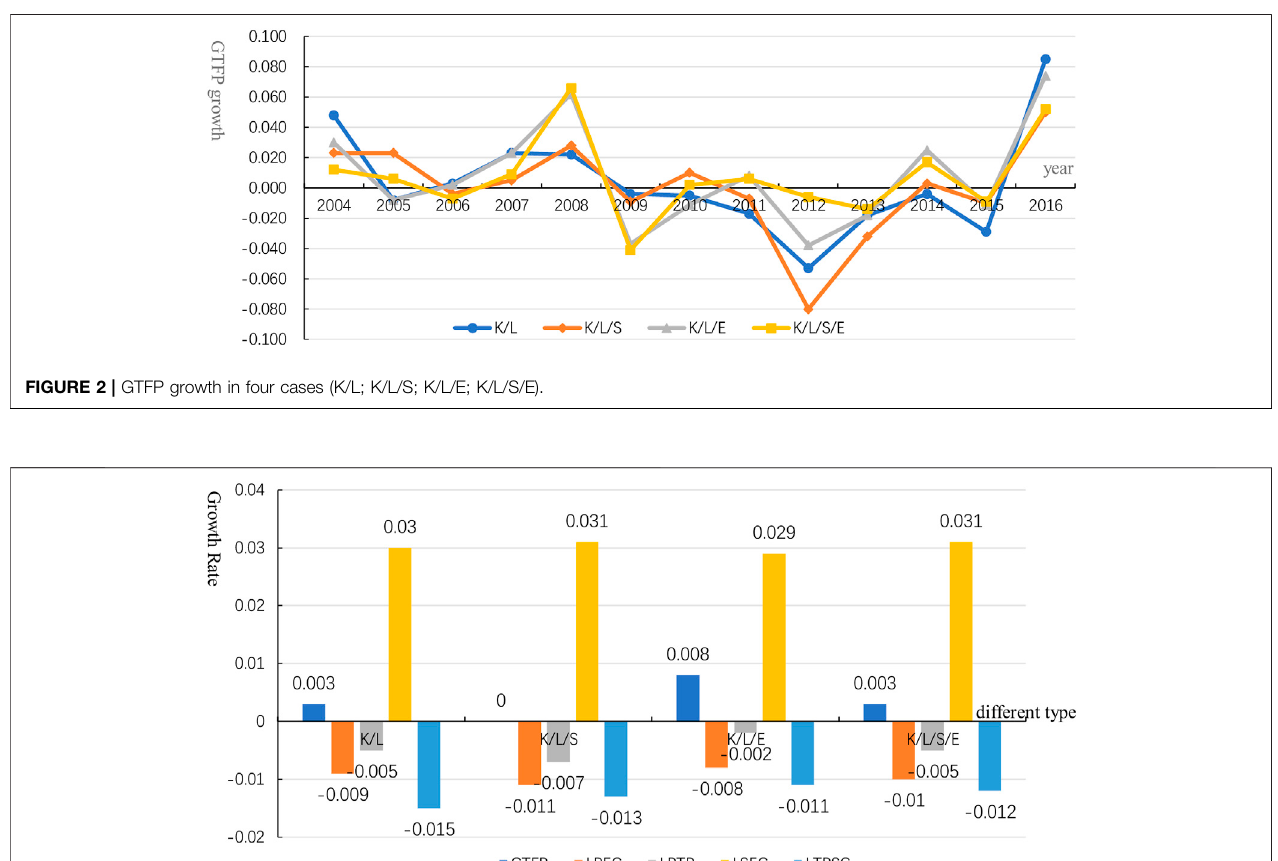
Frontiers in Environmental Science |